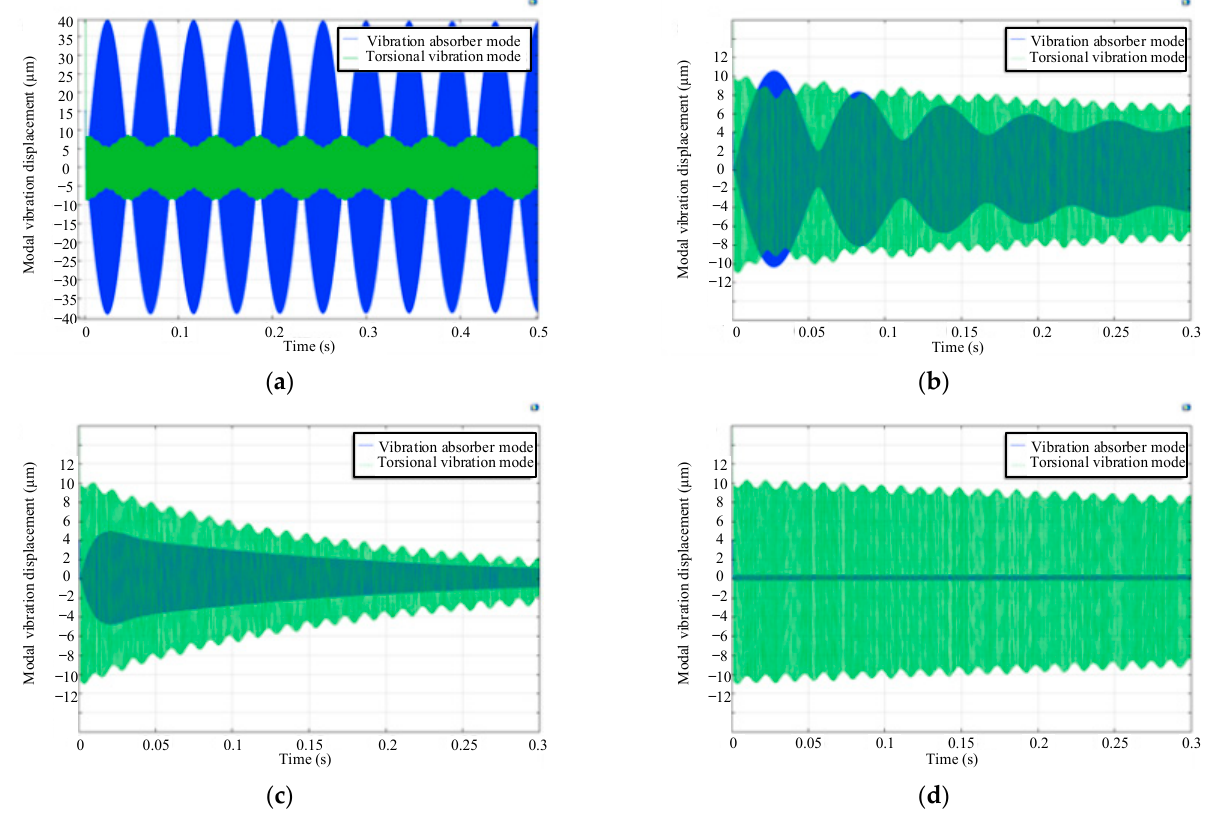
Figure 10. Influence of vibration absorber damping: ( a ) c = 0; ( b ) c = 1; ( c ) c = 9.5; ( d ) c = 100. As shown in Figure 10a, the internal resonance has been successfully